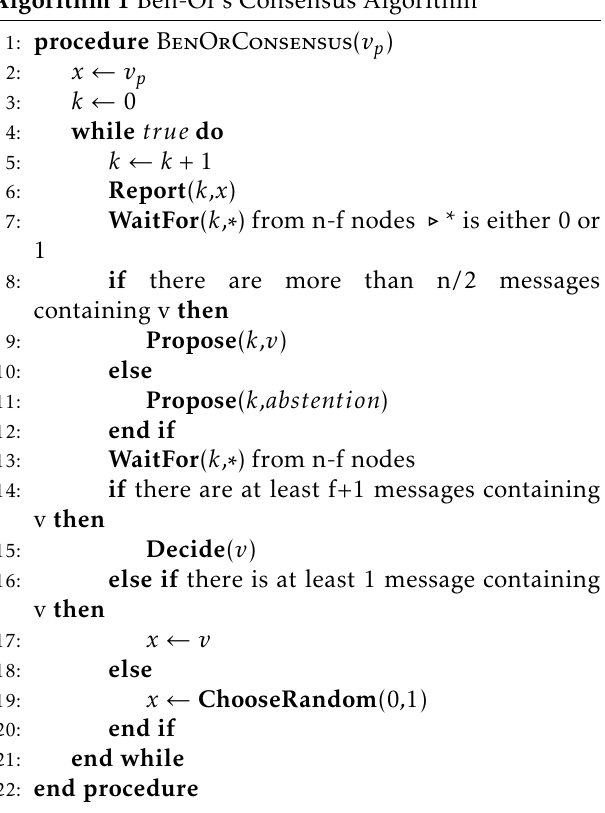
Algorithm 1 Ben-Or’s Consensus